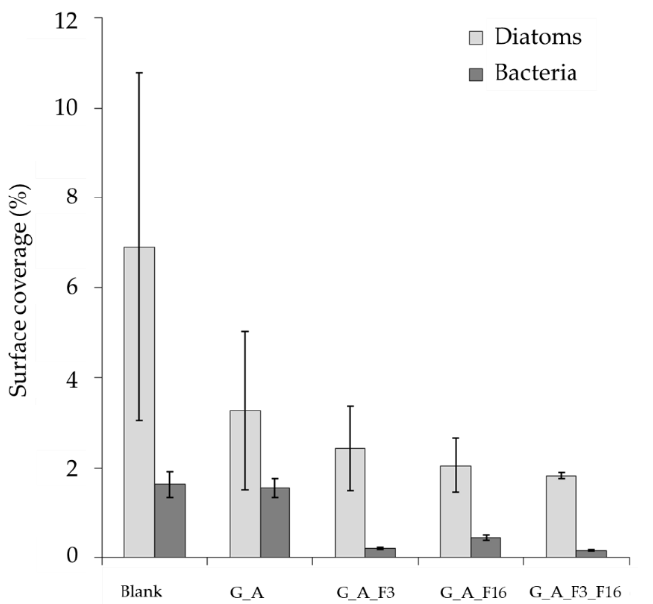
Figure 16. Percentage of area covered by adhered diatoms and Gram-negative bacteria as estimated by SEM imaging.